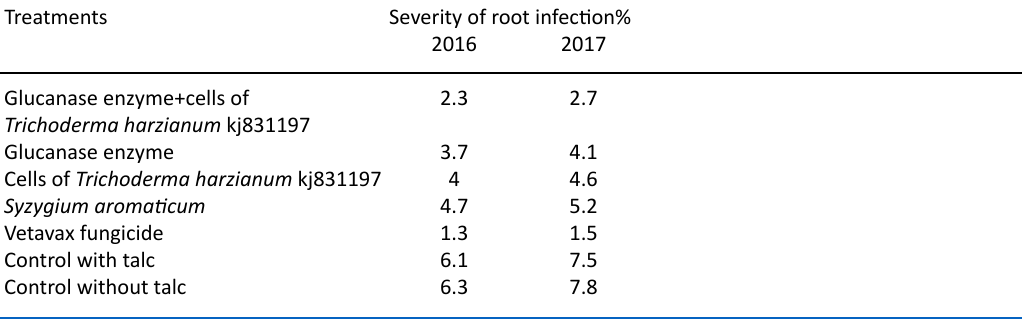
table 2. Effect of different treatments on disease severity of roots after 150 days of growing time